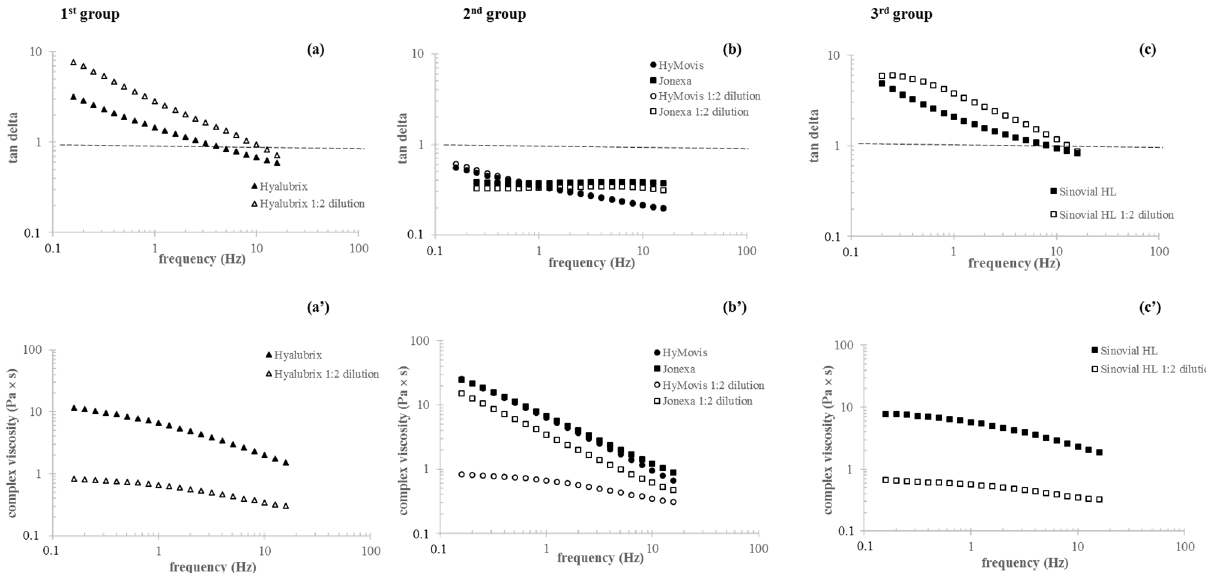
Figure 2. Tan delta and complex viscosity as function of frequency for the HA-based formulas as commercialized ( a – c ) and after 1:2 dilution in physiological medium ( a ’– c ’). Measurements were performed at 37 °C.